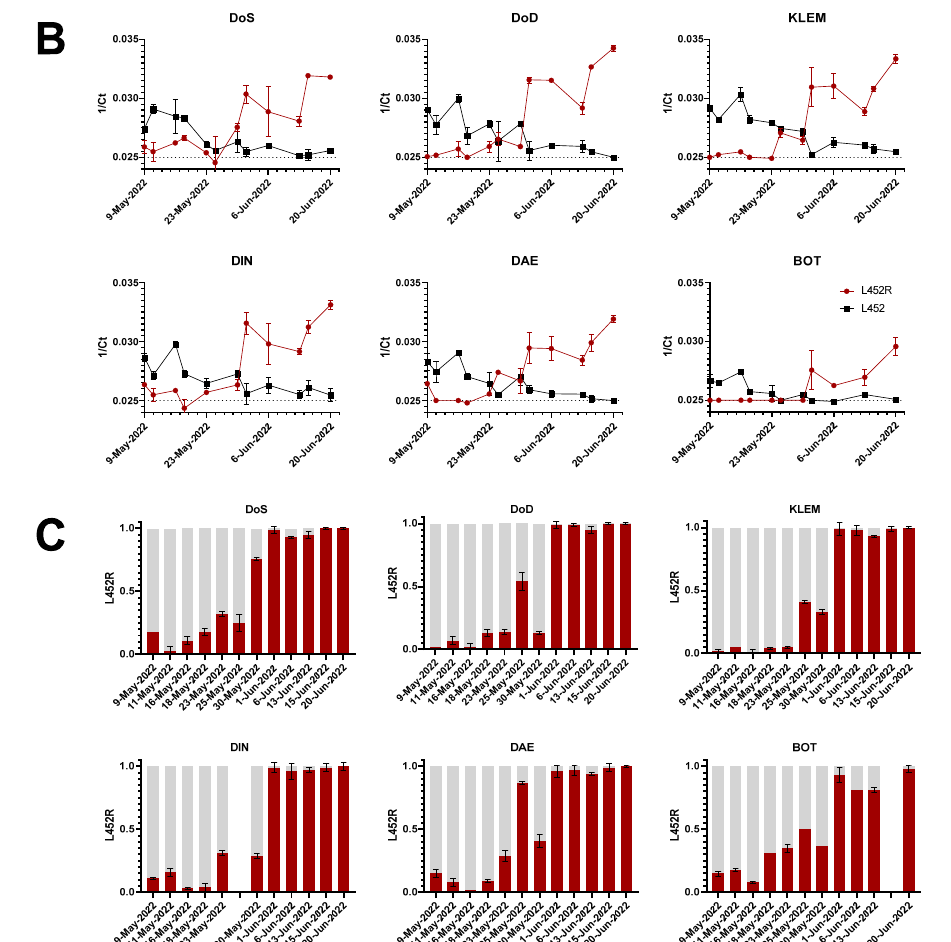
Figure 2. Monitoring of SARS-CoV-2 viral RNA fragments in six different wastewater treatment plants. Wastewater samples (single samples per day) were analyzed by RT-qPCR in two technical replicates for ( A ) the presence of SARS-CoV-2 viral load (red) using N1/N2 targets (simultaneously detected in a dual target assay), PMMoV (black line), and ( B ) Omicron BA.4/BA.5 characteristic mutation L452R in the SARS-CoV-2 spike. The corresponding reciprocal ct values (1/ct) are illustrated for each WWTP. The dotted line indicates the limit of detection (>ct = 40). ( C ) Red (L452R) and grey (L452) bars represent the ratio between BA.4/BA.5 and non-BA.4/BA.5 fractions estimated by calculating the ct values for both targets. For technical reasons, no data are available for DIN from 25 May 2022 and for BOT from 15 June 2022.